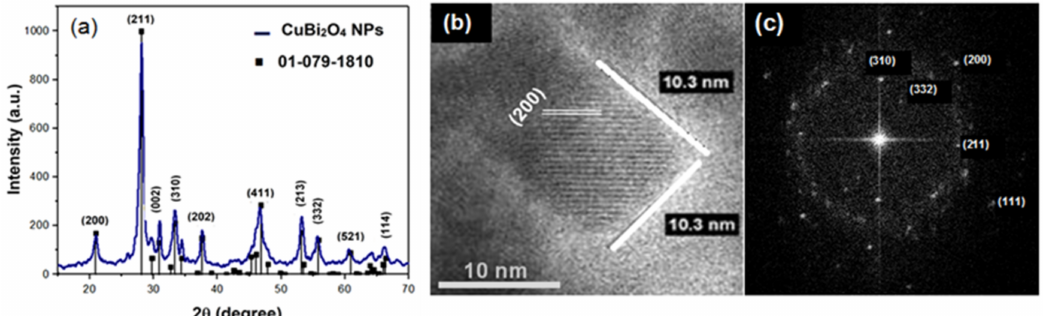
Figure 2. ( a ) Powder XRD pattern and ( b ) HR-TEM micrograph of CuBi 2 O 4 NPs. In the corresponding FFT pattern ( c ), the indexed planes belong to the tetragonal crystal structure of CuBi 2 O 4 .